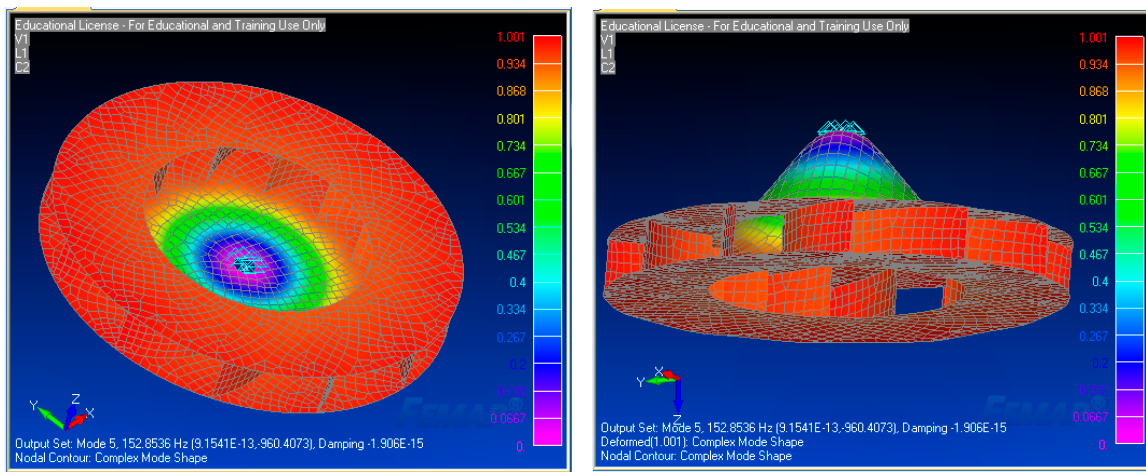
Figure 13. Dynamic simulation fifth mode, 152.8536 Hz.